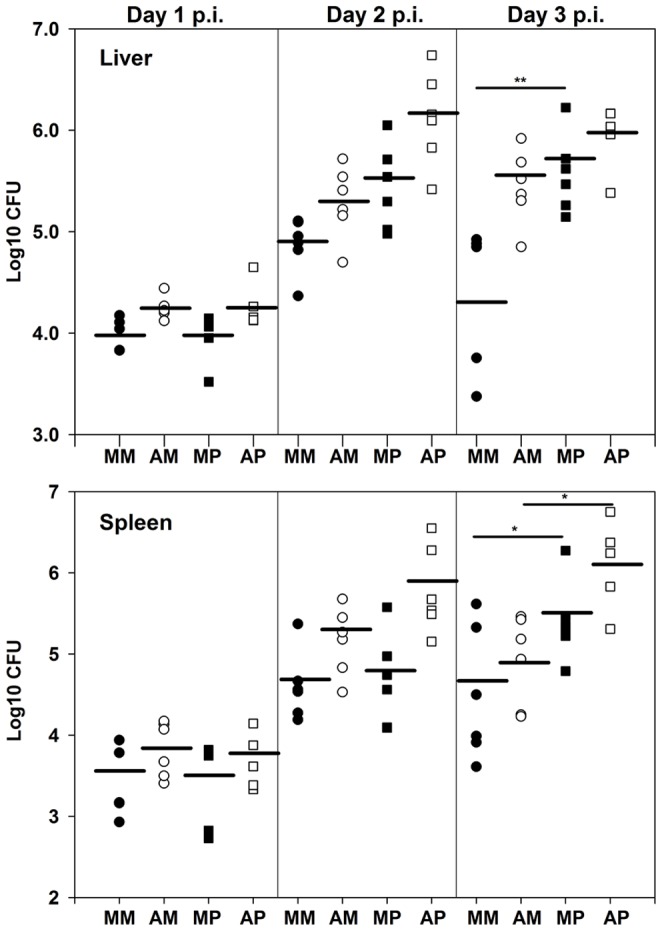
PMNs were critical to control growth of 28/37°C-pregrown ΔyopM-1 Y. pestis in liver but not spleen.B6 mice were ablated for PMNs (open symbols) by treatment with anti-Ly6G antibody on days -1 and +1 of infection; mock-treated mice (closed symbols) received nonspecific rat IgG. The mice were infected with 400 28/37°C-grown parent (squares) or ΔyopM-1 (circles) Y. pestis, and viable numbers (CFU) were determined on d 1, 2, and 3 p.i. Group labels: MM, mock-treated mice infected with ΔyopM-1 Y. pestis; AM, Ablated mice infected with ΔyopM-1 Y. pestis; MP, mock-treated mice infected with the parent strain; AP, ablated mice infected with the parent strain. The data were obtained in two experiments, each with 2 to 3 mice per group, for 4 to 6 mice total for each category. Each symbol gives the bacterial burden of one mouse; the horizontal lines mark the geometric means of the pooled data for each category. Statistically significant differences by Student's t test occurred on d 3 p.i. as indicated: *, P<0.05; **, P<0.01.